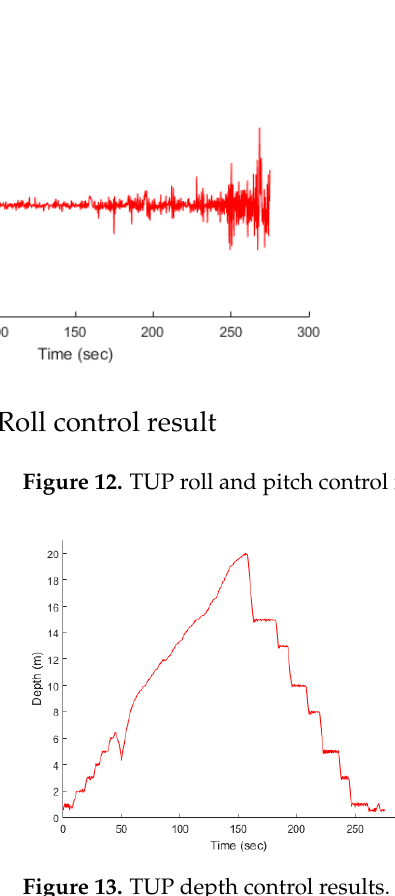
Figure 13. TUP depth control results.